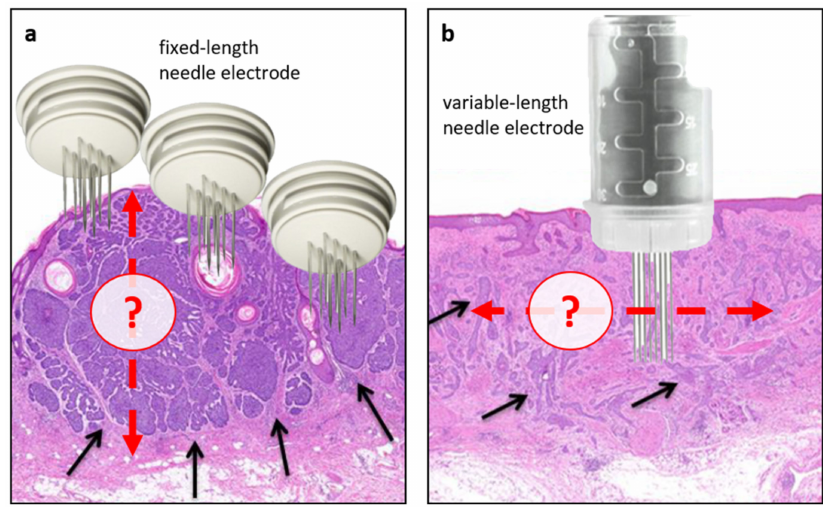
Figure 3. Intraprocedural challenges of ECT in BCC. As a principle, effective ECT treatment delivery relies on adequate chemotherapy distribution within the tumour (following i.v. or i.t. administration) and complete coverage with electric fields (electroporation). In this regard, lower response rates are associated with previous radiotherapy (likely due to its effect on microcirculation) and the insufficient electroporation of tumour margins, an aspect closely associated with the modalities of electrode application. Generally, the extent and depth of electrode insertion are operator-dependent and based on clinical judgment. ( a ) An example of nodular BCC with well-circumscribed areas of cancer cells (black arrows) treated with a fixed-length electrode. In this case, the actual BCC depth may be underestimated, thus leaving deep portions of the tumour untreated. ( b ) An example of infiltrative BCC in which the actual extension of the tumour may be challenging to discriminate with potential repercussions on the coverage of lateral tumour margins. Red arrows indicate the potential depth ( a ) or extension ( b ) of electrode